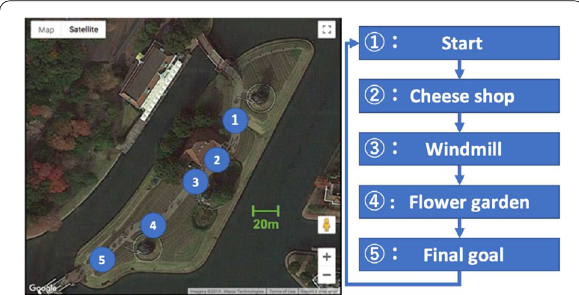
Fig. 24 Environment for the guided tour experiment. The blue circles describe the target points of the guided tour, and the flowchart describes the flow of the experiment and each